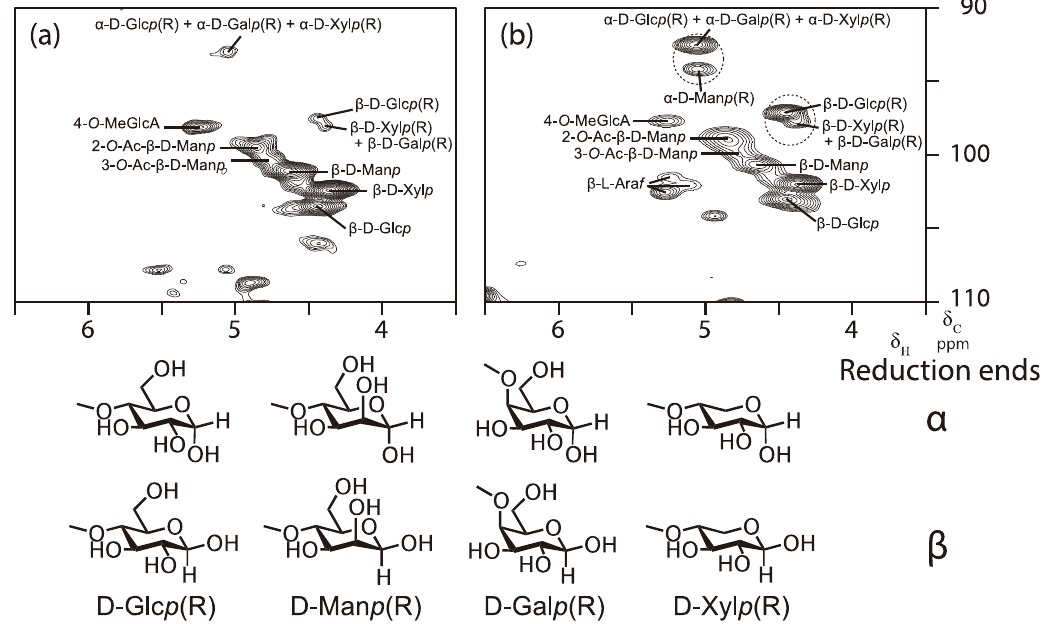
Figure 2. HSQC-NMR spectra in the anomeric region of the wood (Japanese cedar) ( a ) and the sucrose/citric acid type adhesive wood-based molding (W80) ( b ).